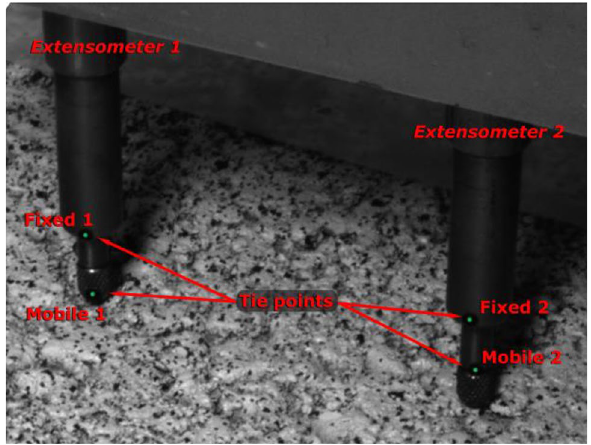
Figure 3. GOM’s auto-detectable targets (tie points) attached to the extensometers.